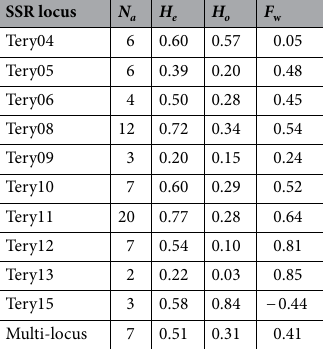
Table 3. Statistical summary of the diversity of T. erytreae SSR markers. Mean values are represented in the table. N a , allele number; H e and H o , expected and observed heterozygosity, respectively; F w , Wright’s fixation index over the whole population.